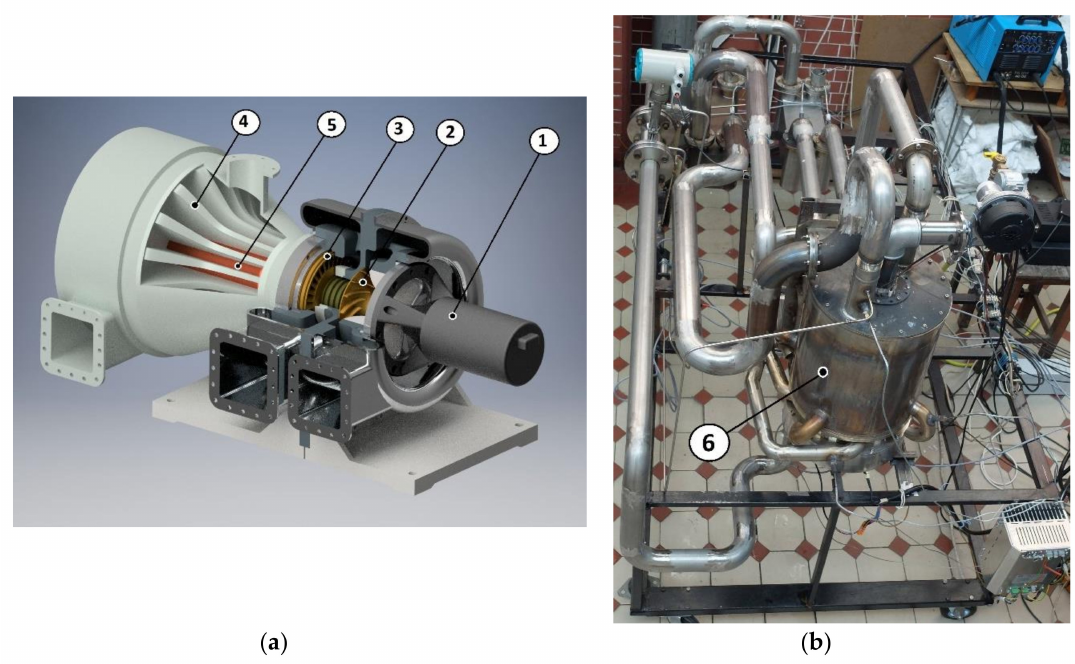
Figure 7. The example of the experimental variant of a gas turbine working according to the Ericsson cycle ( a ), turboset research stand with isothermal expansion ( b ), where: 1—electric generator, 2—compressor, 3—turbine rotor, 4—expansion nozzle, 5—burner, 6—built-up